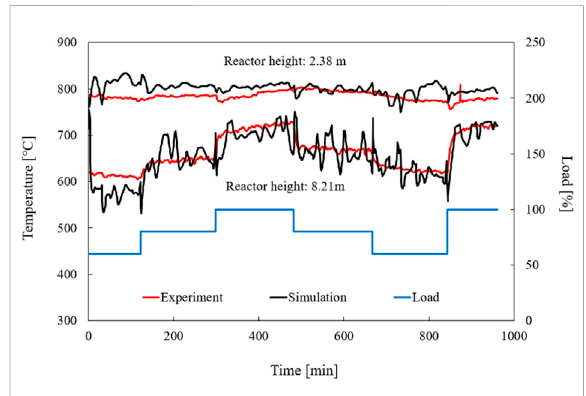
FIGURE 18 Comparison of the temperature difference of the cooling water of the cooling